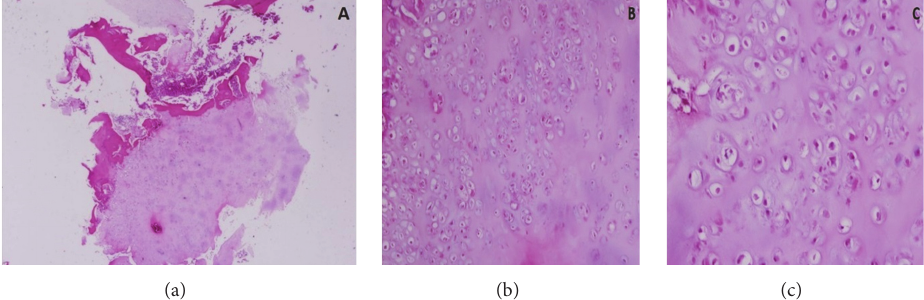
Figure 4: (a) Lobule of cartilaginous lesion partially surrounded by a rim of lamellar bone (H&E × 20); (b, c) relatively cellular cartilaginous lesion with mild to moderate nuclear pleomorphism (H&E × 100 and ×